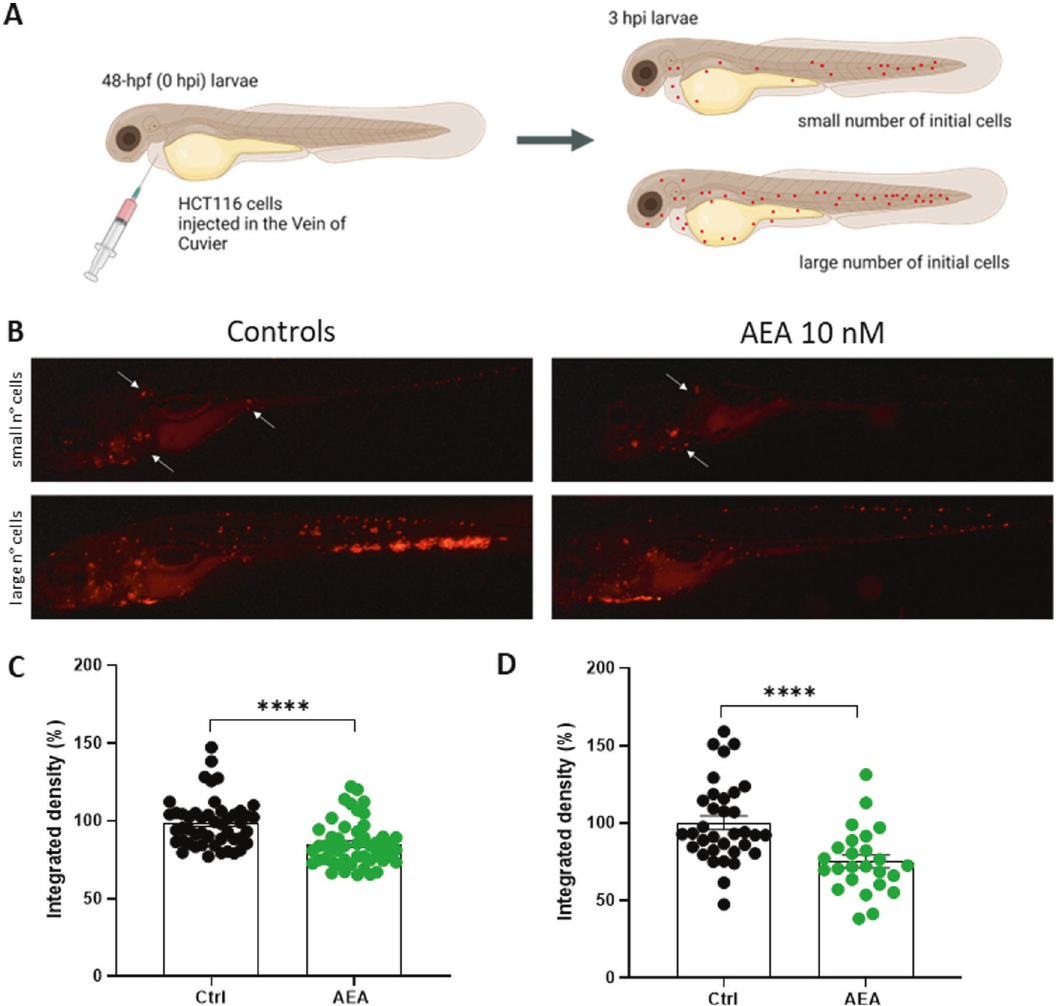
Fig. 3 AEA exposure reduces HCT116 metastatic ability. A HCT116 cells were directly injected into the Vein of Cuvier of 48-hpf WT larvae. The image shows the experimental procedure and the division of xenografts considering the number of HCT116 circulating cells 3 hpi. Image created with Biorender.com. B Stereomicroscope Representative Images of 3dpi Ctrl- (on the left) and AEA exposed xenografts (on the right). White arrows pinpoint HCT116 cells in metastasis. C , D Integrated density of HCT116 metastatic tumor cells in 3 dpi zebra fi sh larvae injected with small ( C ) and large ( D ) numbers of cells. The mean value of the integrated density in Ctrl was set as 100%. The error bar indicates SEM. (Small: Ctrl n = 48; AEA n = 50. Large: Ctrl n = 34; AEA n = 25 from three independent experiments). Statistical analysis was performed using Student ’ s t -test. **** p <